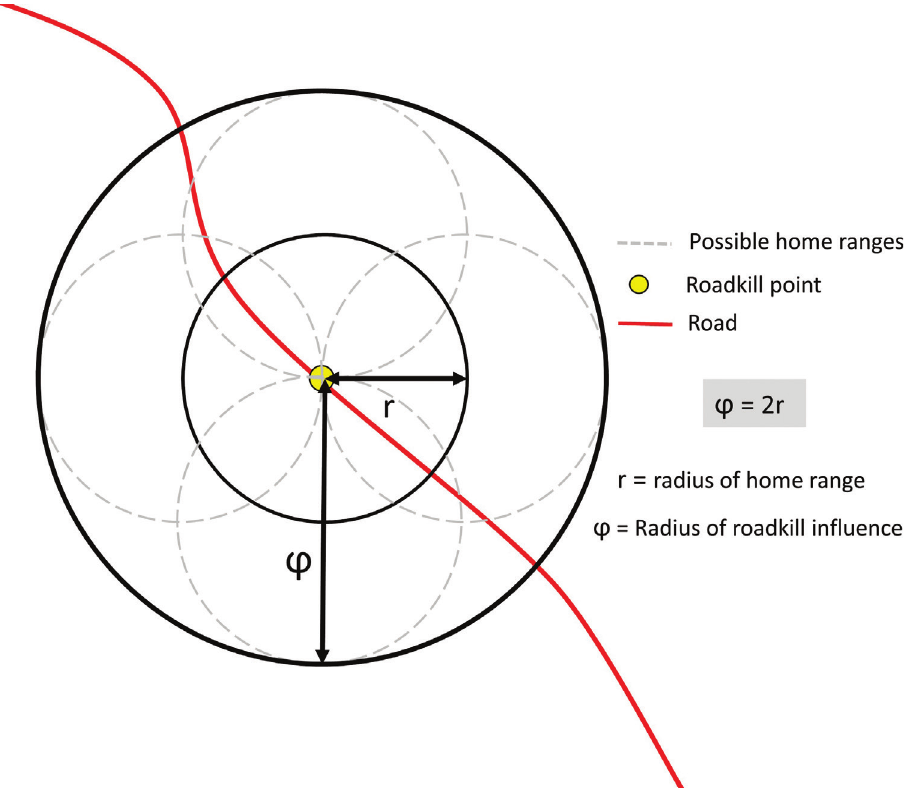
Figure 1. Scheme exemplifying the radius of roadkill influence chosen. For a given roadkill point using the simple radius of home range (r), we might exclude some of the landscape characteristics if the roadkill occurred in the border of the home range. Including the possible home ranges (approximated to a circular shape), and doubling the radius ( φ ), we ensure that all landscape composition associated with the roadkill occurrence is incorporated within the